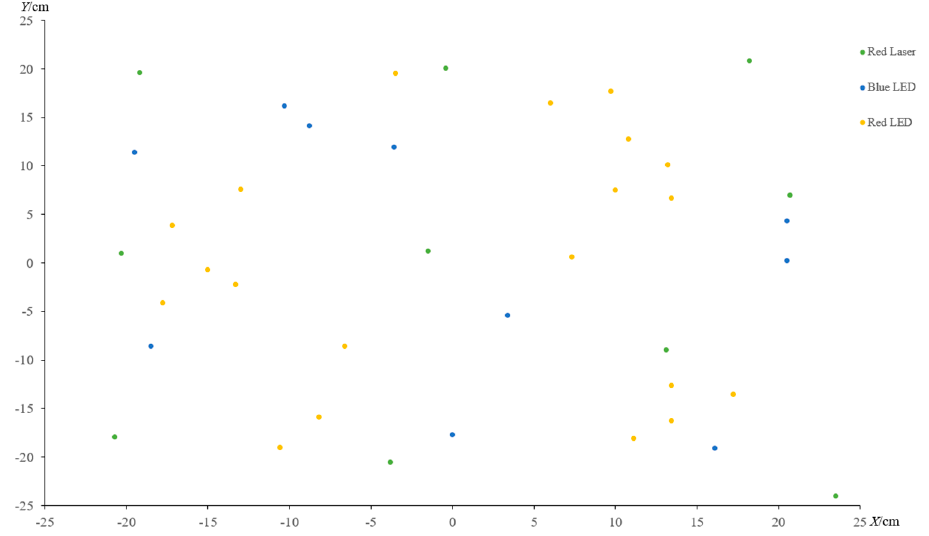
Figure 9. Location of each light source.